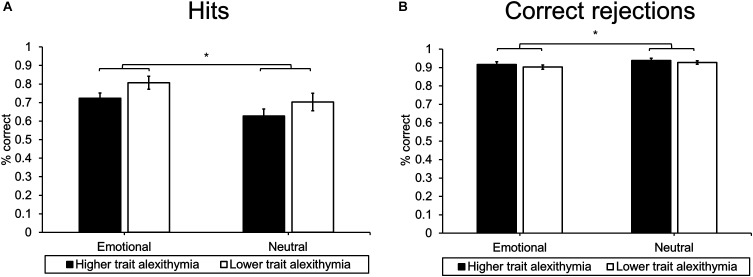
Mean (A) hits and (B) CRs for higher and LTA subgroups. Error bars represent standard error of the mean, ∗indicates p < 0.05.